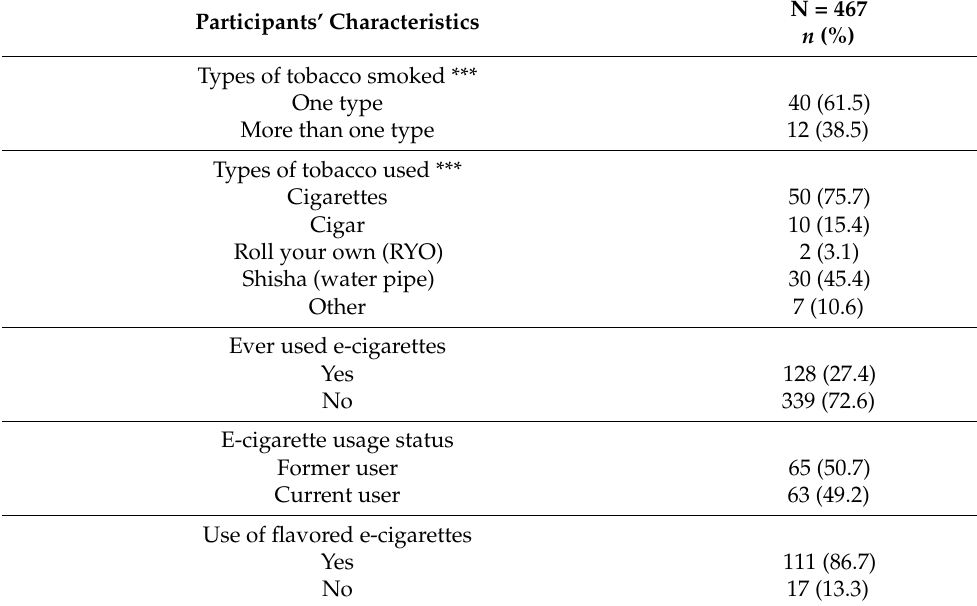
Table 2. Overall knowledge regarding e-cigarettes among first-year university students (N = 467).